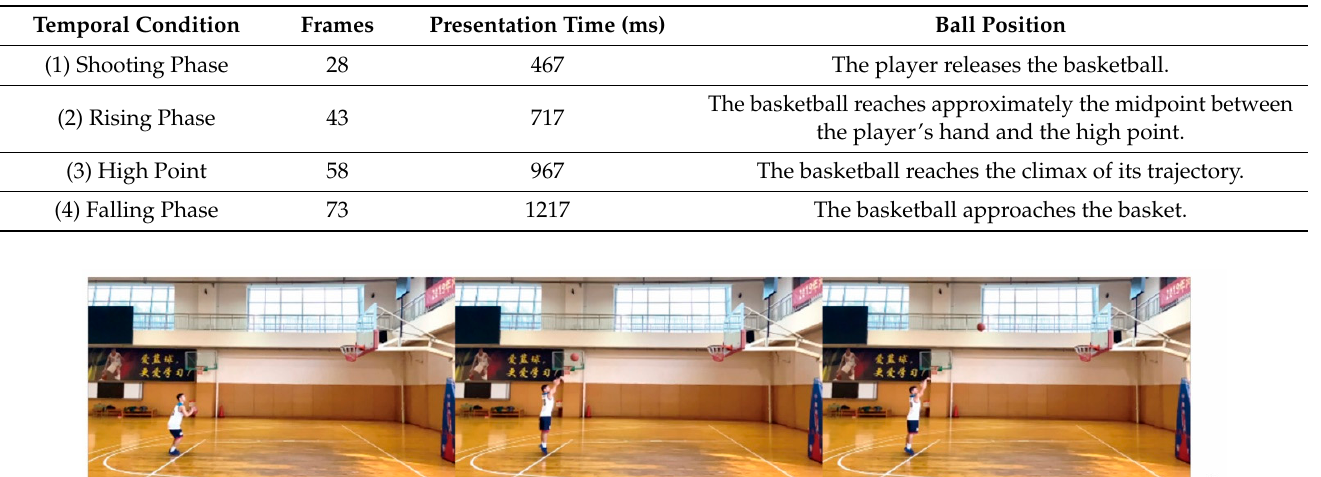
Table 1. Experimental Stimulus Information.